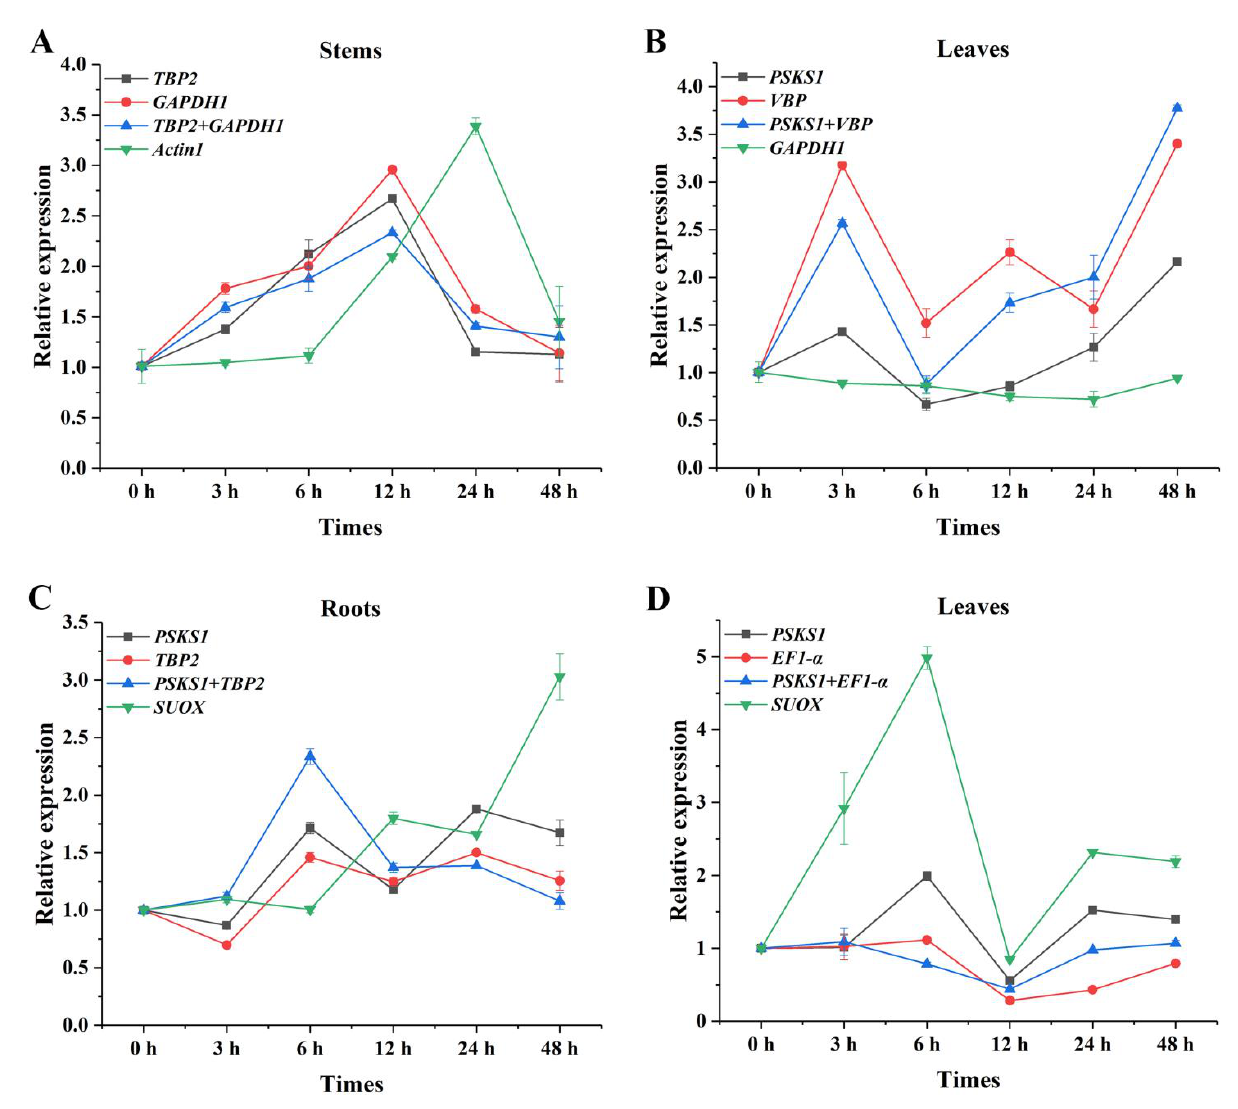
Figure 4. Relative expression level of PAL in the stems and leaves under UV-B stress ( A , B ) and the roots and leaves under high-light stress ( C , D ) when the most and least stably expressed reference genes were used for normalization.